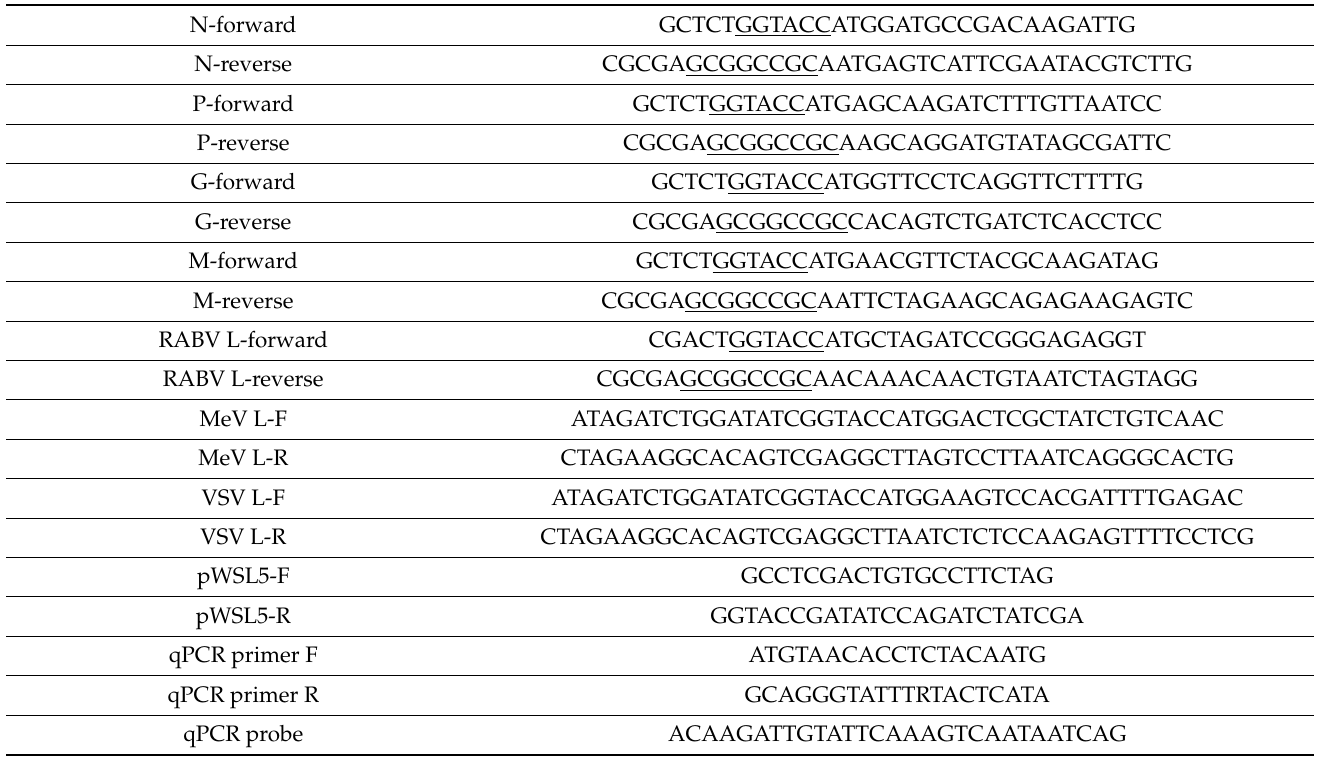
Table 1. Primers used for cloning. The KpnI and NotI sites used for plasmid construction are